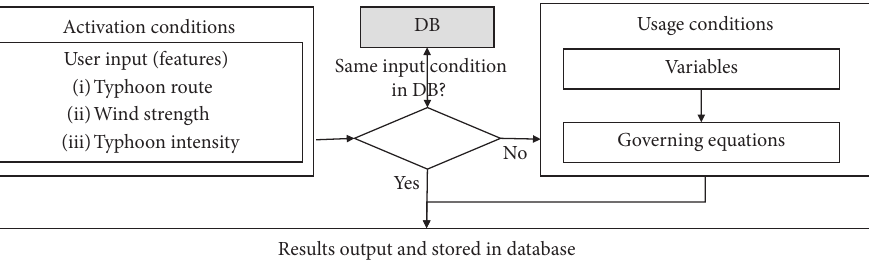
Figure 2: Concept design of the SIND model. Table 1: Information of hazard